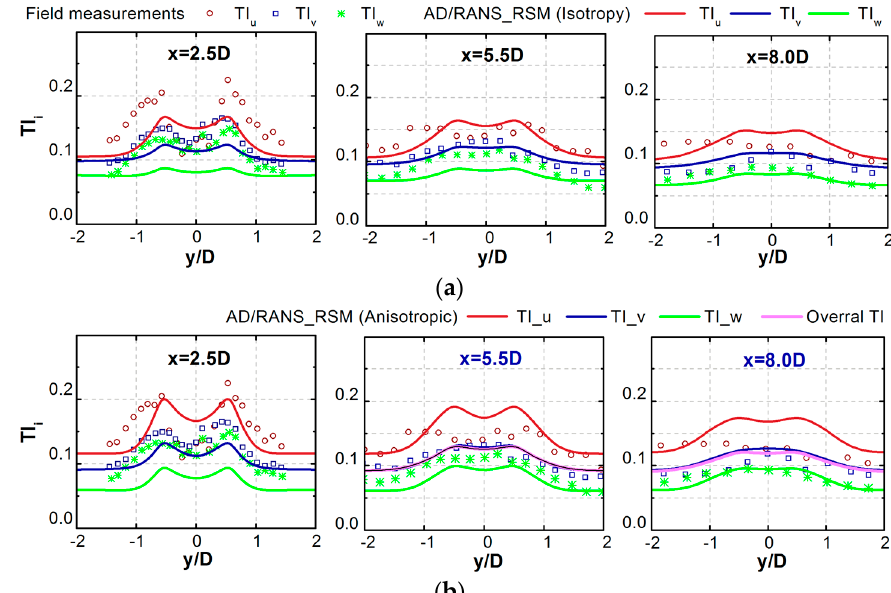
Figure 4. Comparison of turbulence intensity in three flow directions at di ff erent downstream distances. ( a ) Results of the AD / RANS_RSM method under the isotropic inflow condition; ( b ) results of the AD / RANS_RSM method under the anisotropic inflow condition.